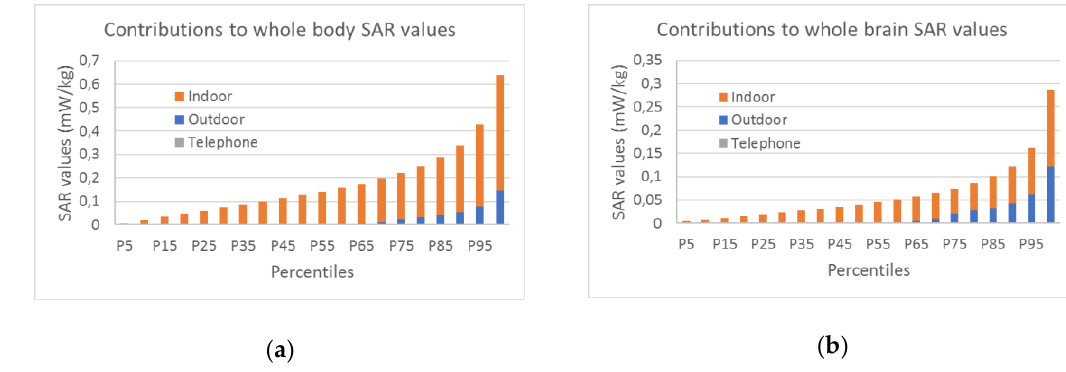
Figure 6. Estimated contributions to SAR values: ( a ) whole body; ( b ) whole brain.